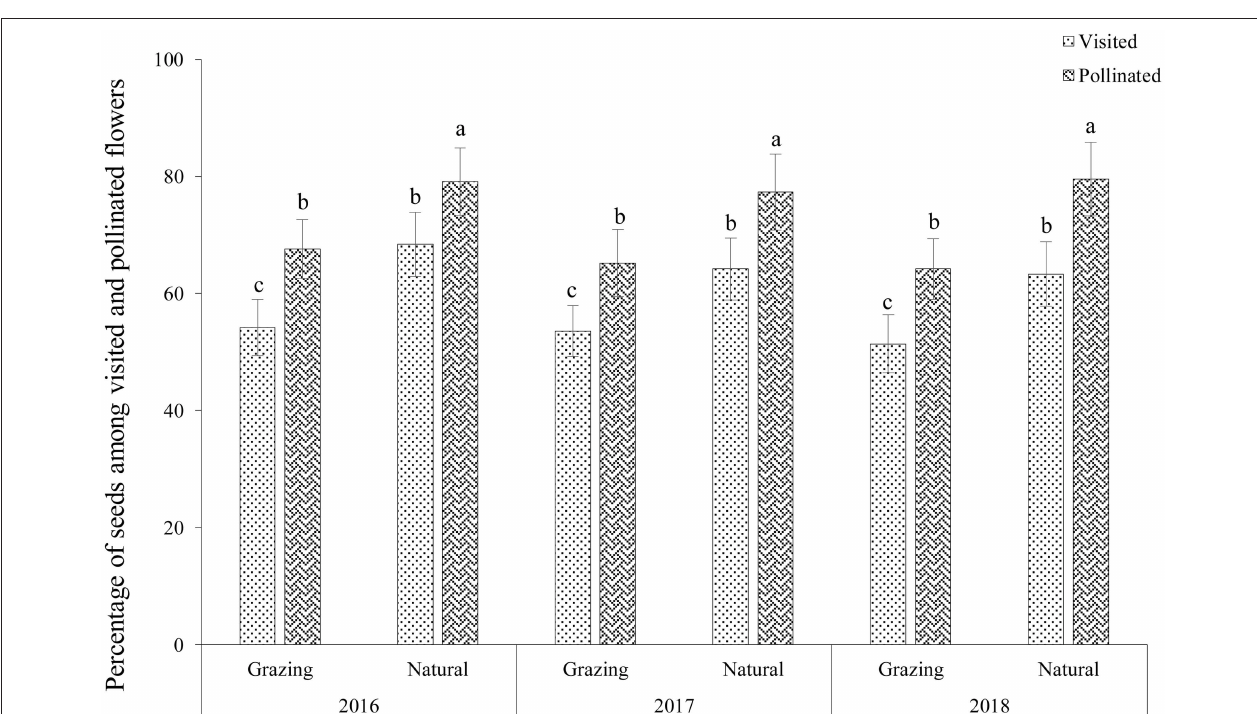
FIGURE 3 | Percentage of seeds among the visited and pollinated flowers of C. microphylla .